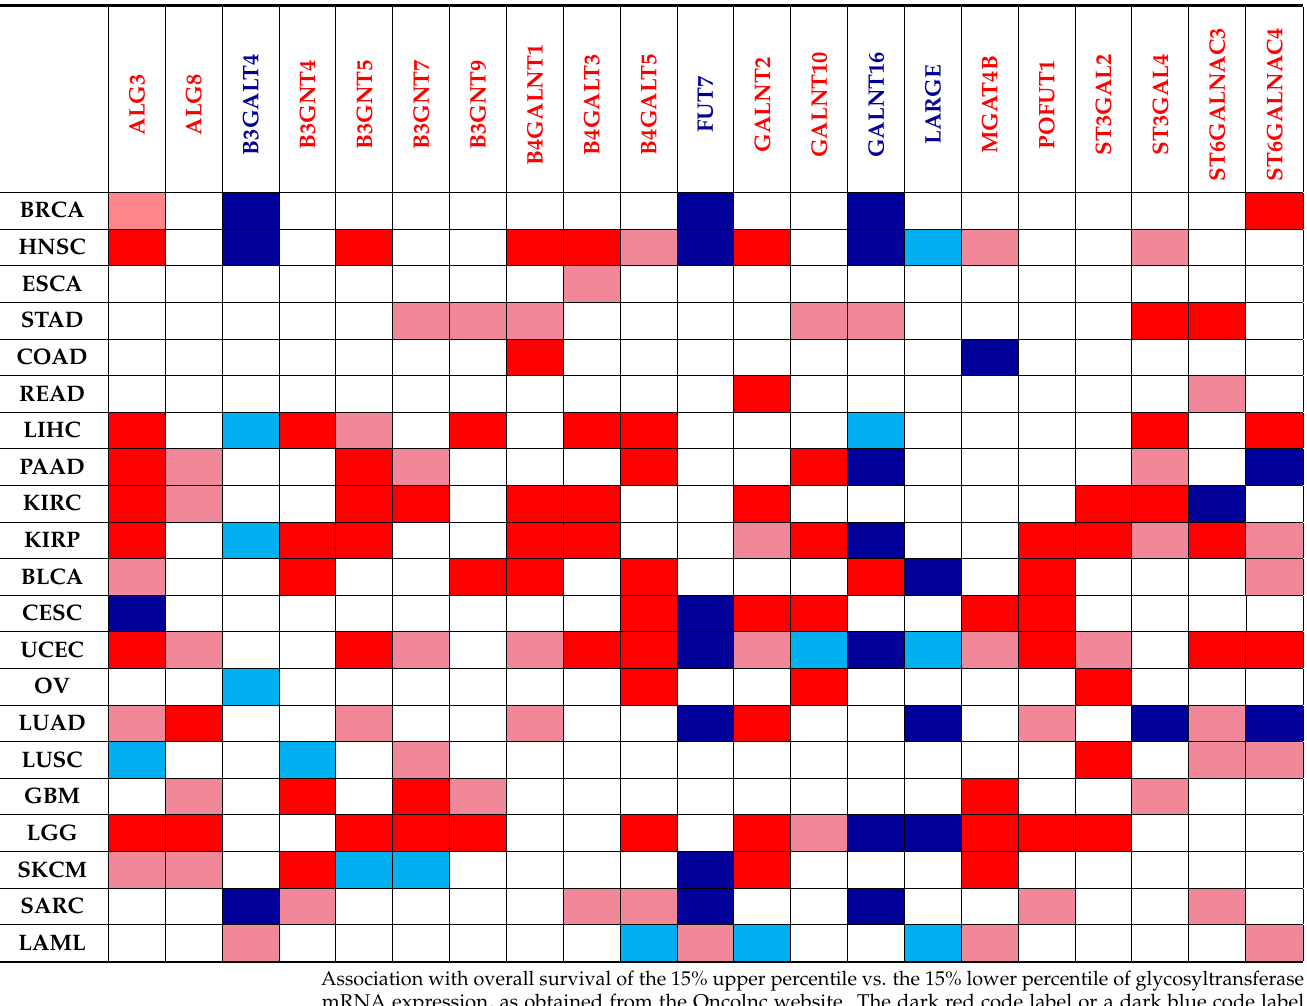
Table 1. Prognostic value in TCGA cohorts of BPA and GPA glycosyltransferases.